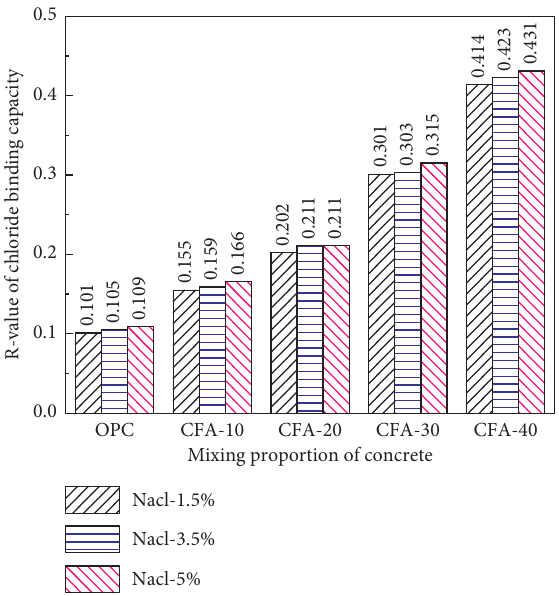
Figure 6: R values of chloride ion binding capacity.